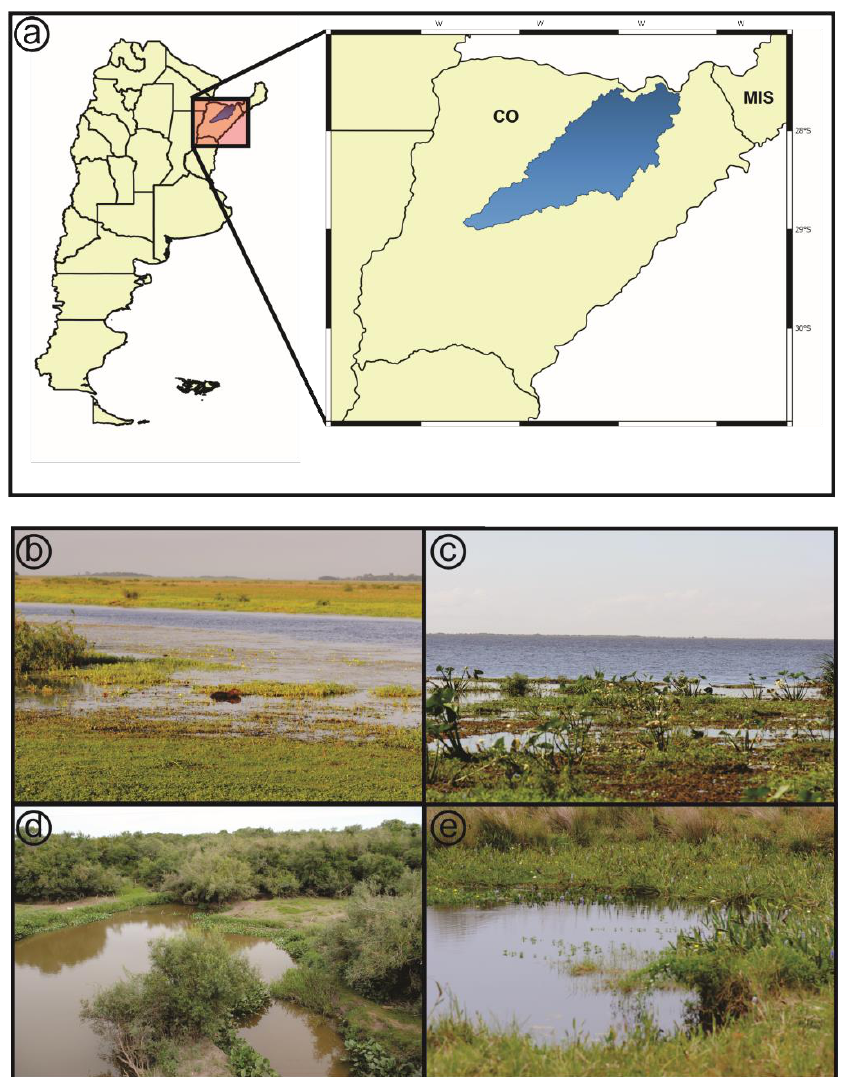
Figure 1. ( a ) Map of Argentina showing the Iberá Depression in the Corrientes province. ( b ) Photo of a typical wetland of the Iberá Depression (San Nicolás, Corrientes), ( c ) Photo of Laguna